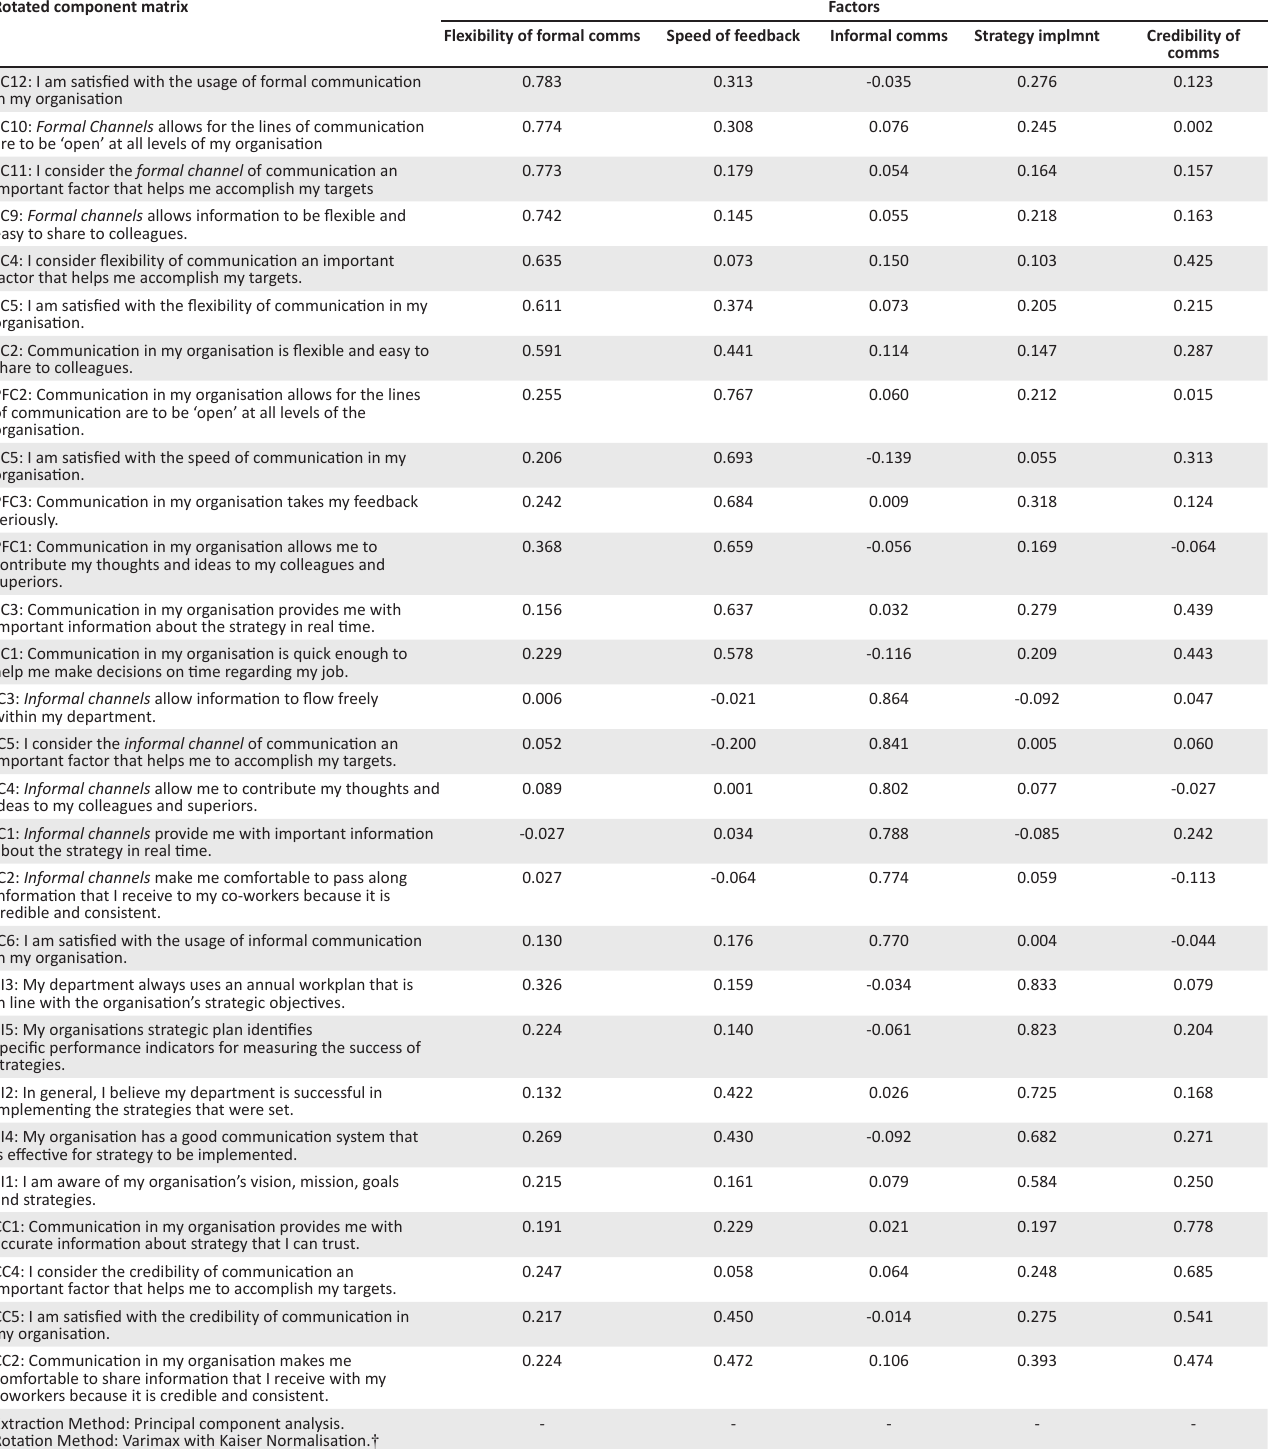
TABLE 1-A1: The results of factor analysis based on rotation component matrix. Rotated component